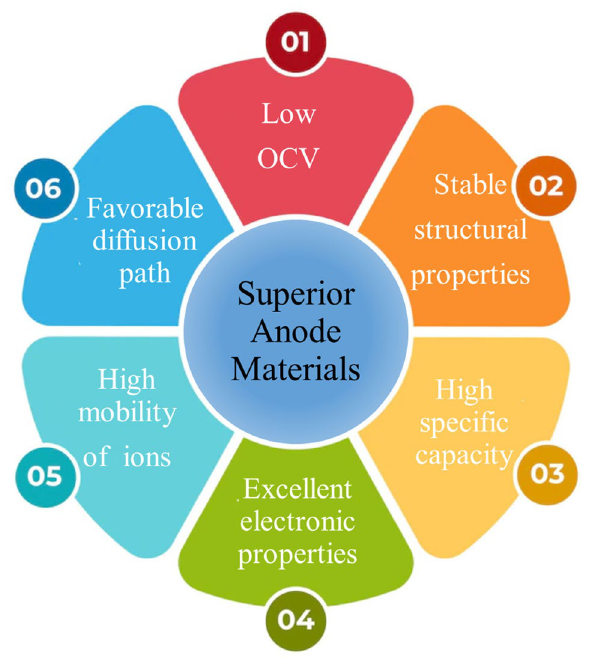
Fig. 17 Properties of a high-performing battery anode